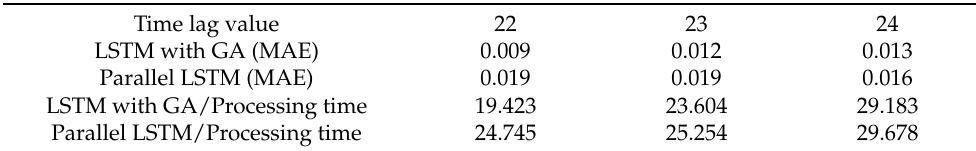
Table 5. MAE variations over different time-lag value for LSTM with GA method and parallel LSTM